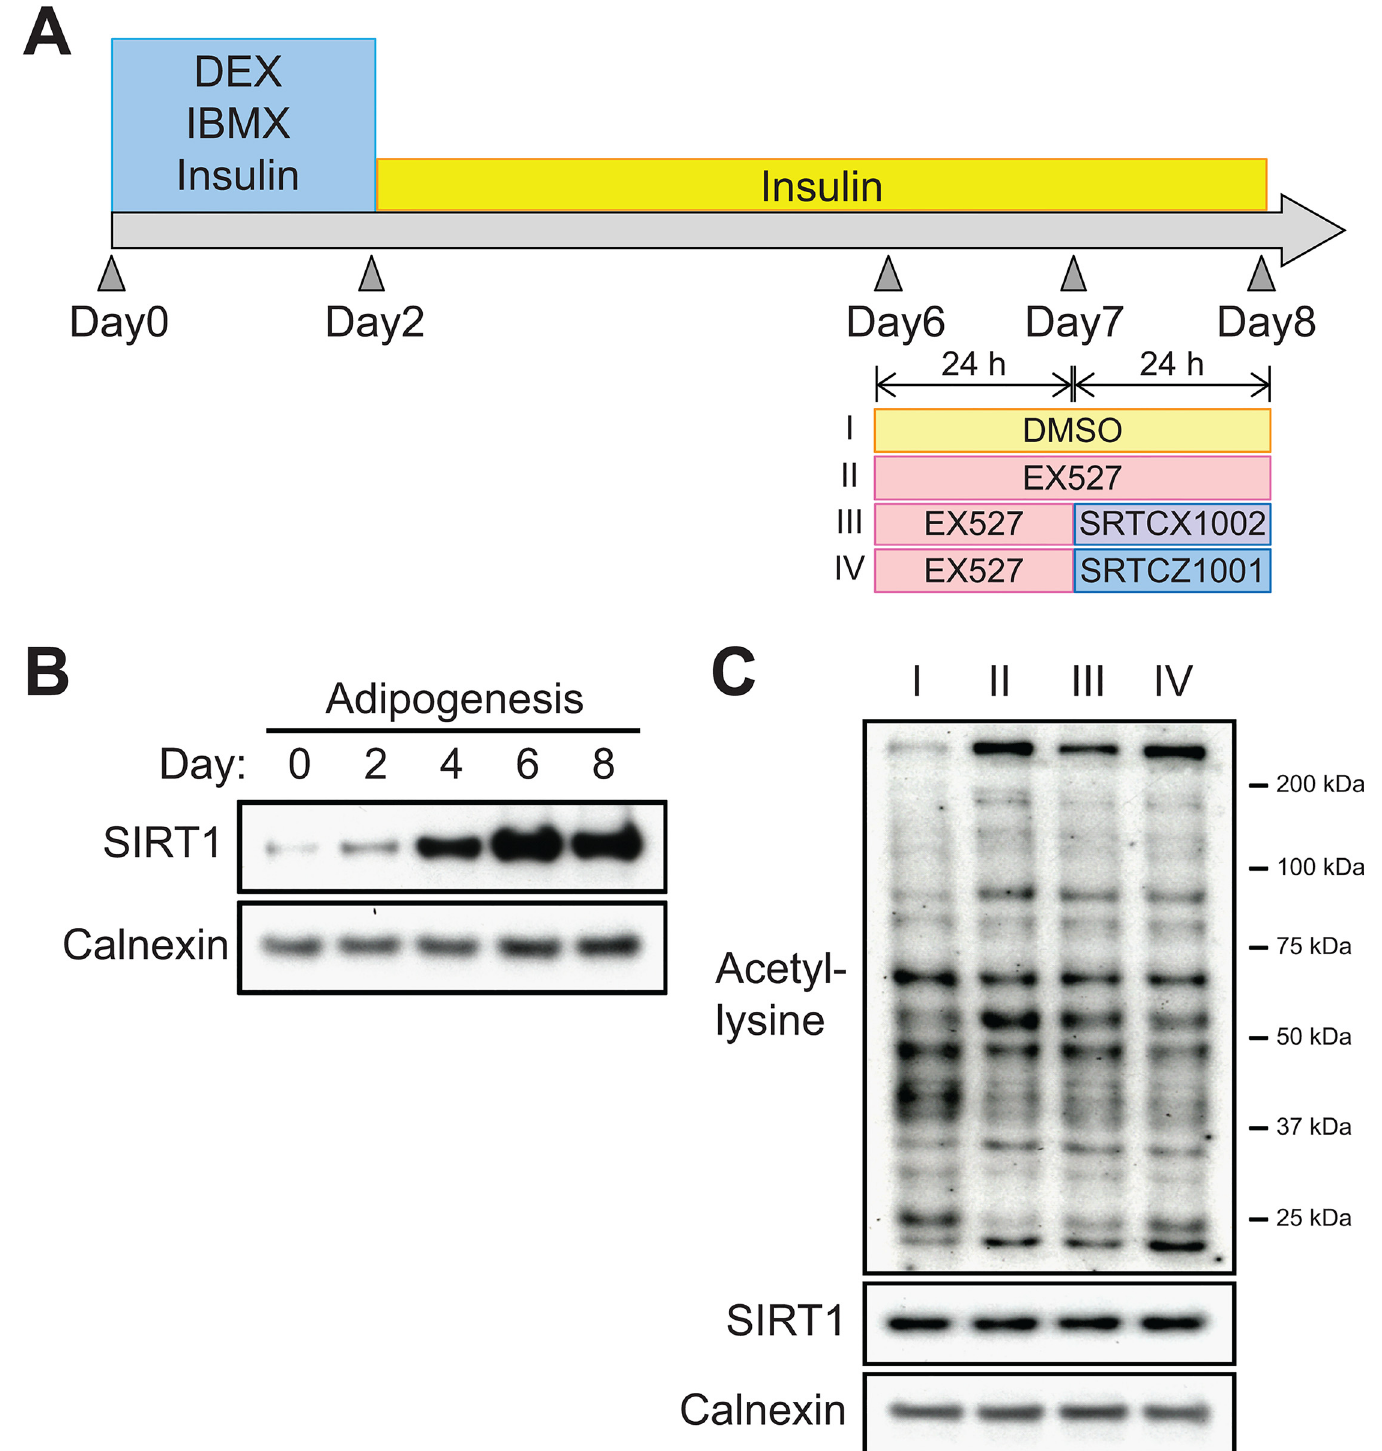
Fig 2. Patterns of global protein acetylation after SIRT1 modulator treatments in 3T3-L1 mature adipocytes. (A) Schematic illustration of the experimental procedure. Briefly, 3T3-L1 cells were differentiated into mature adipocytes for 6 days. Then, the mature adipocytes were treated with SIRT1 modulators as follows: (I) DMSO for 48 hours; (II) EX527 for 48 hours; (III) EX527 for 24 hours followed by a switch to SRTCX1002 for 24 hours; and (IV) EX527 for 24 hours followed by a switch to SRTCZ1001 for 24 hours. (B) SIRT1 protein levels were examined at the indicated times during 3T3-L1 adipogenesis by western blotting using an antibody against the C-terminal portion of SIRT1. Calnexin was used as a loading control. (C) Patterns of global